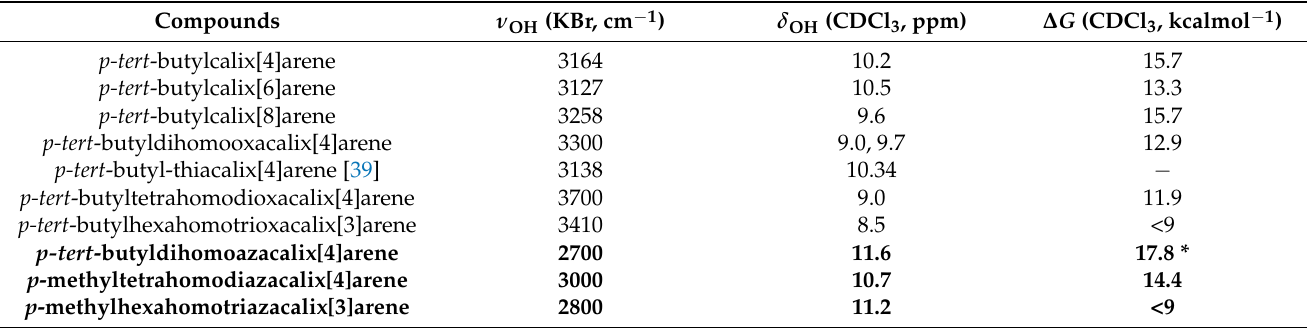
Table 2. Spectral data of various calixarene analogs [1].